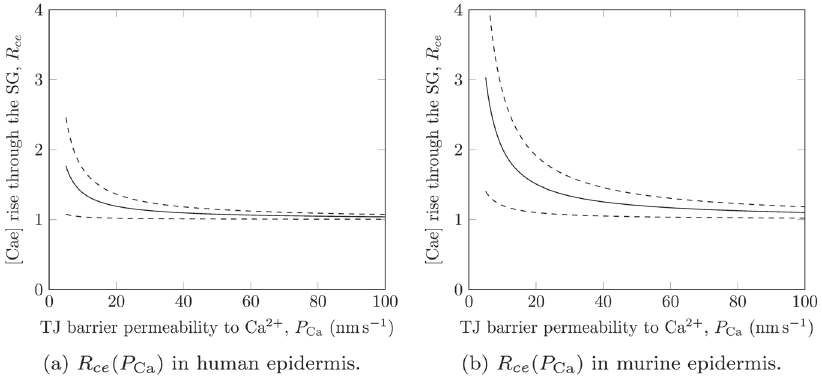
Figure 5. Extracellular calcium rise through the SG vs TJ permeability to calcium predicted by our model. The solid and dashed lines represent the mean values and uncertainty bounds ( ± SD) respectively.